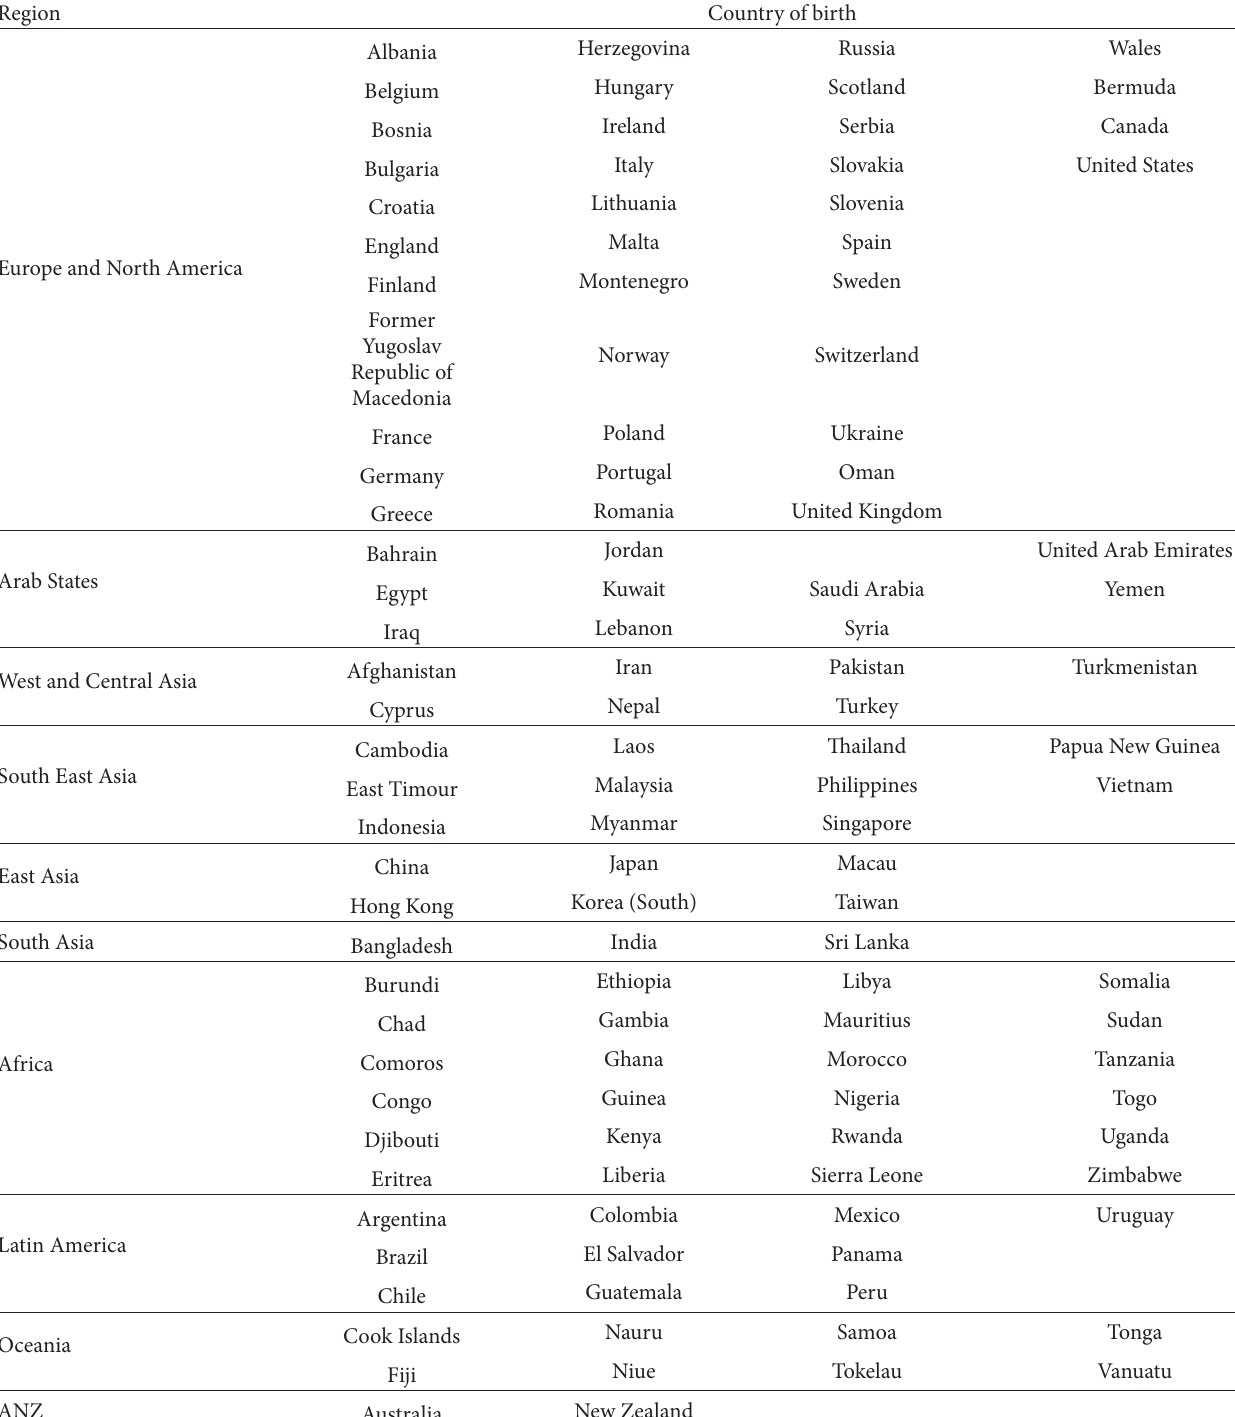
Table 1: List of included countries by